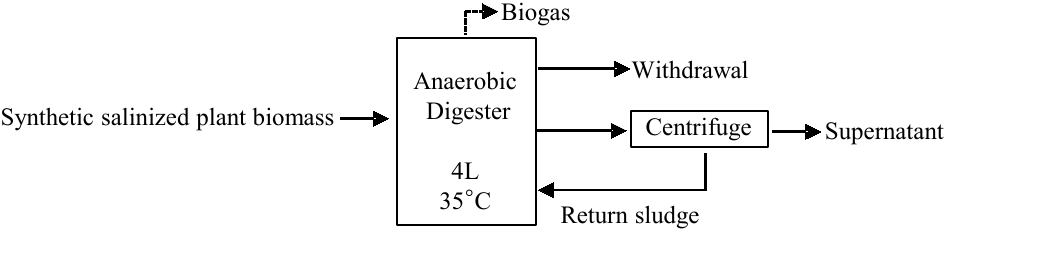
Figure 2. Continuous AD reactor operation flow. Table 1. Feed substrates and conditions of the two